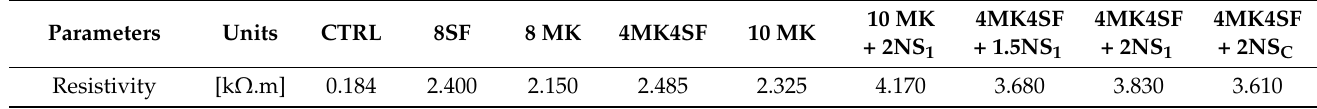
Table 7. Resistivity values of the main